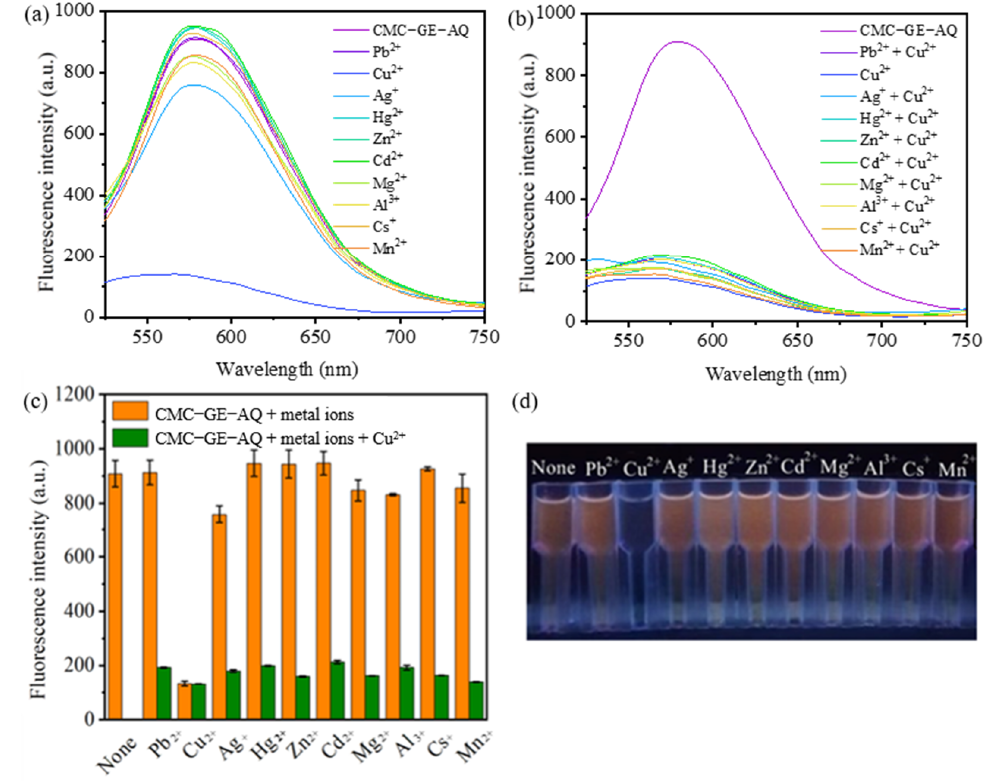
Figure 6. ( a , b ) Fluorescence spectra and ( c ) maximum fluorescence intensity of CMC−GE−AQ solution with different metal ions and other metal ions coexisting with Cu 2+ . ( d ) Fluorescence photographs of CMC−GE−AQ solution with different metal ions under 365 nm UV lamp. (CMC−GE−AQ: 1.5 × 10 −4 g mL −1 ; solvents: DMF/H 2 O solution ( v / v = 8/2, pH = 7); metal ions: 10 −4 mol L −1 ; excitation wavelength: 425 nm; excitation slit: 5 nm.)